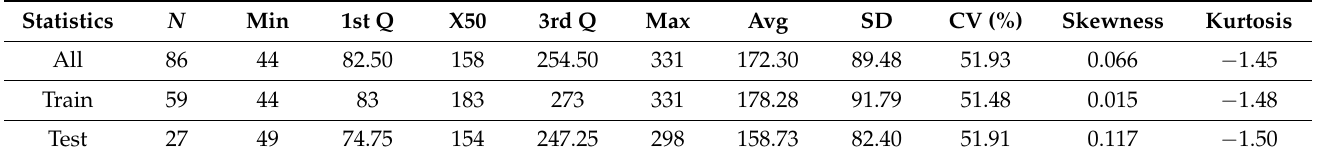
Table 1. Statistical indices of the evaporation data set used to verify the